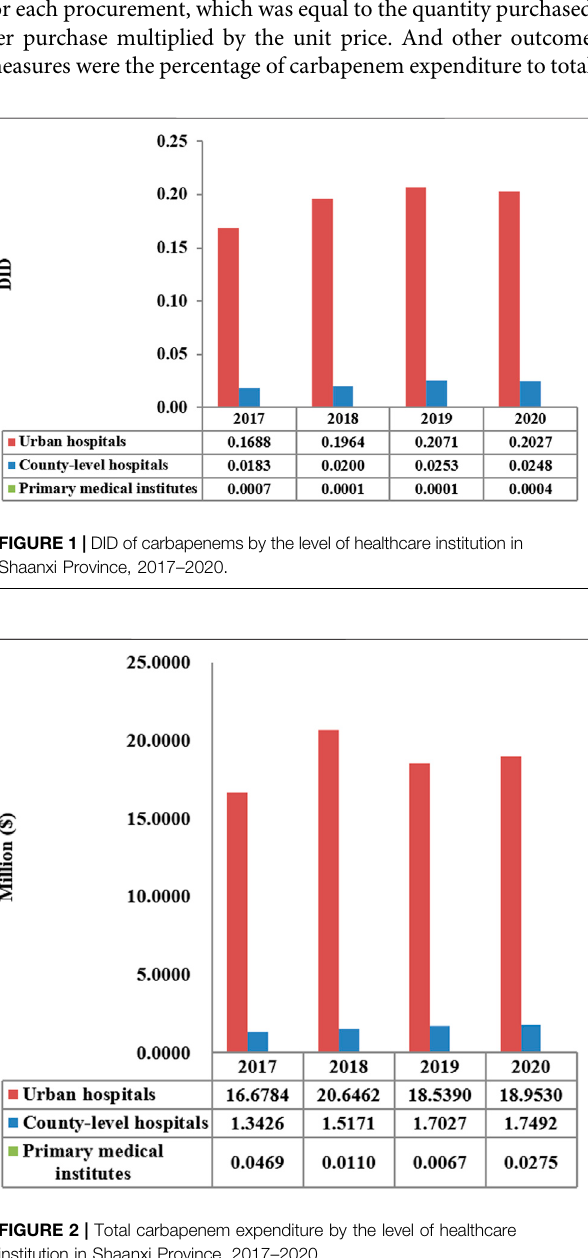
Frontiers in Pharmacology |